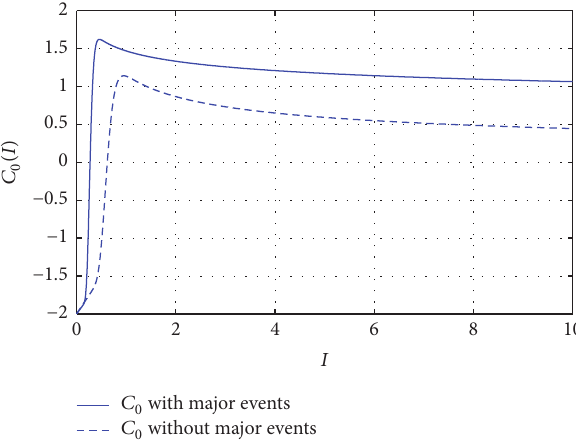
(𝑡 − 𝑡 ) = 1; 𝑉 1 = 1; 1 0 0 = 2.